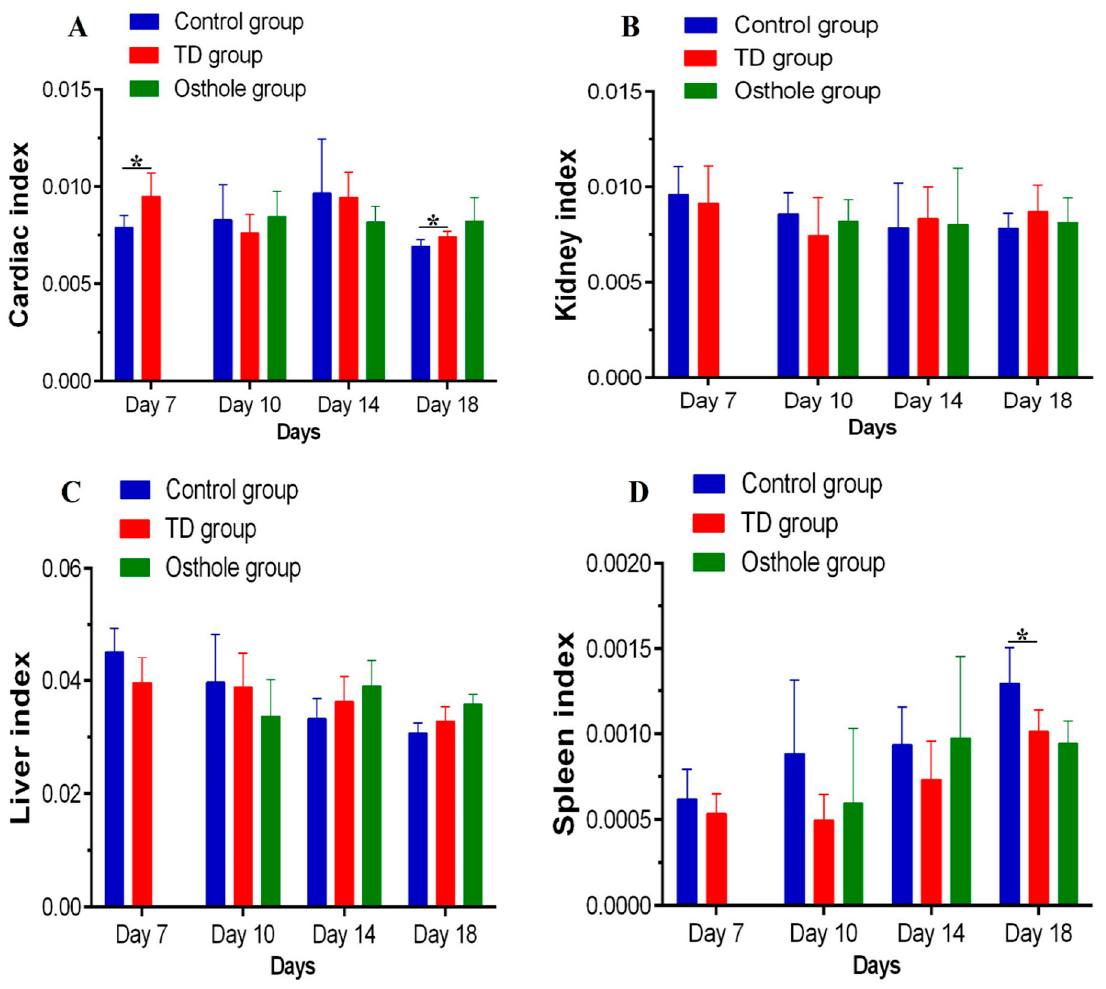
Figure 8. Visceral organs indices among groups on various days: ( A ) cardiac index, ( B ) kidney index, ( C ) liver index, and ( D ) spleen index.